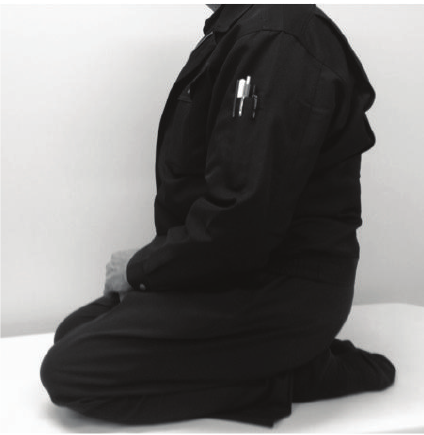
Figure 8: The patient could sit on his heels 2 years after